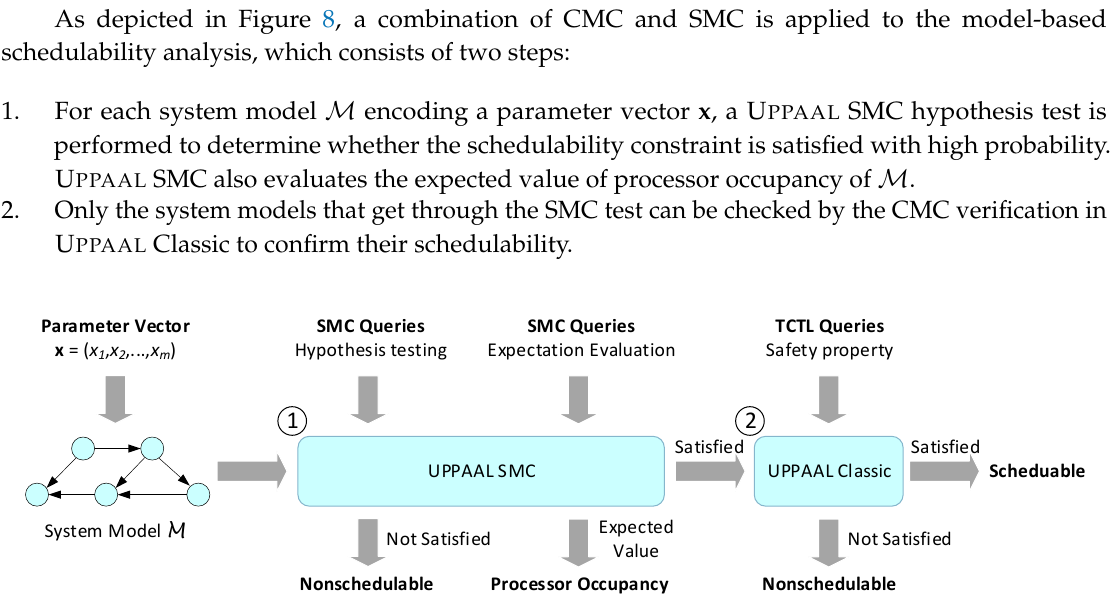
Figure 8. Schedulability analysis of the model-based